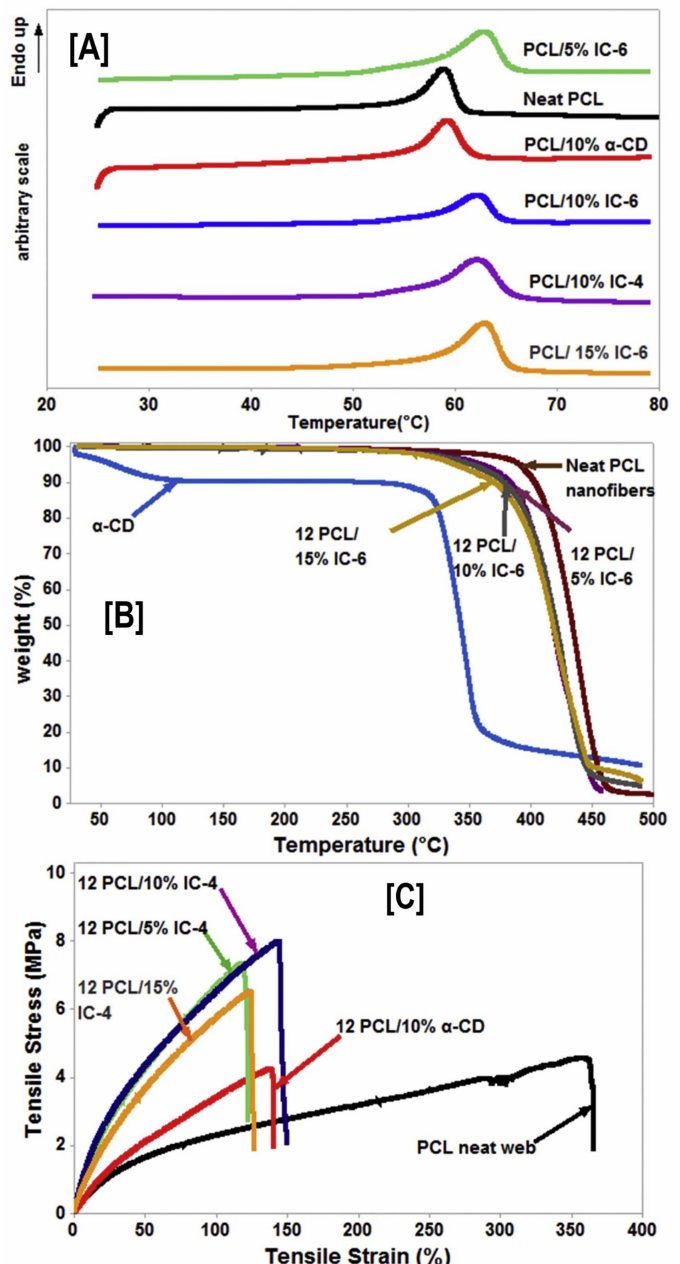
Figure 7. Structure–property relationships (thermal and mechanical), due to the presence of intact non-stoichiometric inclusion complexes (n-s PCL- α -CD-IC) in PCL nanofibers. The presence of intact (n-s PCL- α -CD-IC) caused increases (~5 ◦ C) in PCL melting temperature ( A ), irrespective of the stoichiometric ratio of the IC or the wt % loading of those ICs in the nanofibers. Likewise, the degradation temperature of the α -CD phase significantly increased in those composites, indicating the presence of α -CD in complexed state ( B ). Finally, intact ICs caused changes in the mechanical behavior (increased modulus value and decreased elongation) of the composites. Images adapted with permission from [95]. Copyright Elsevier Ltd.,